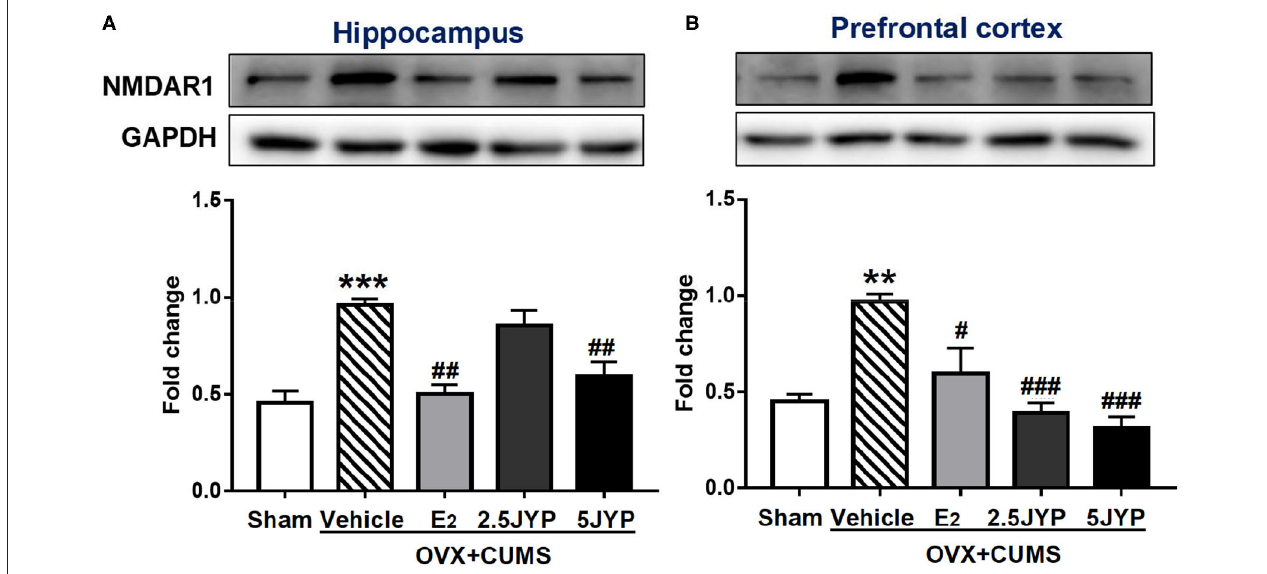
FIGURE 8 | Effects of 2.5 g/kg JYP (2.5 JYP), 5.0 g/kg JYP (5 JYP), and 0.3 mg/kg estradiol (E2) on the expression of N-methyl-D-aspartate (NMDA) receptor unit 1 (NMDAR1) in the hippocampus (A) and prefrontal cortex (B) . Data are expressed as mean ± SEM ( n = 3) and examined with one-way analysis of variance (ANOVA),